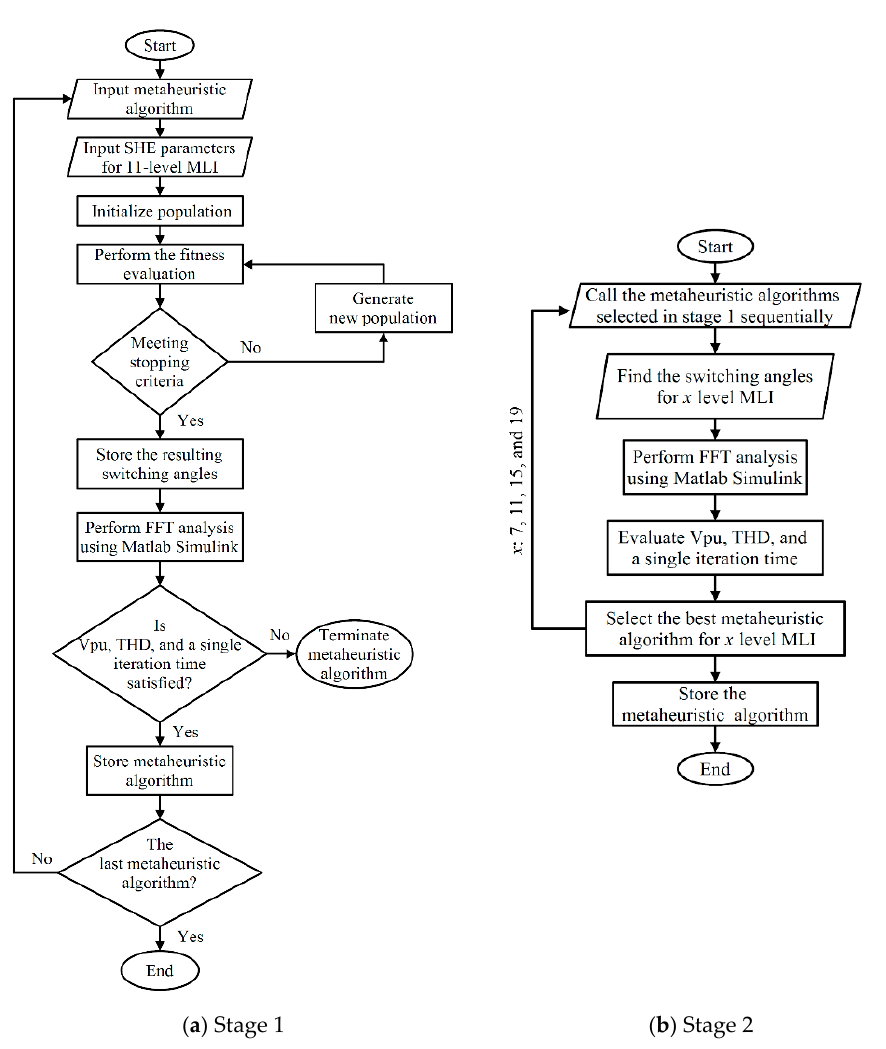
Figure 2. Flowchart of the process ( a ) stage 1; ( b ) stage 2.